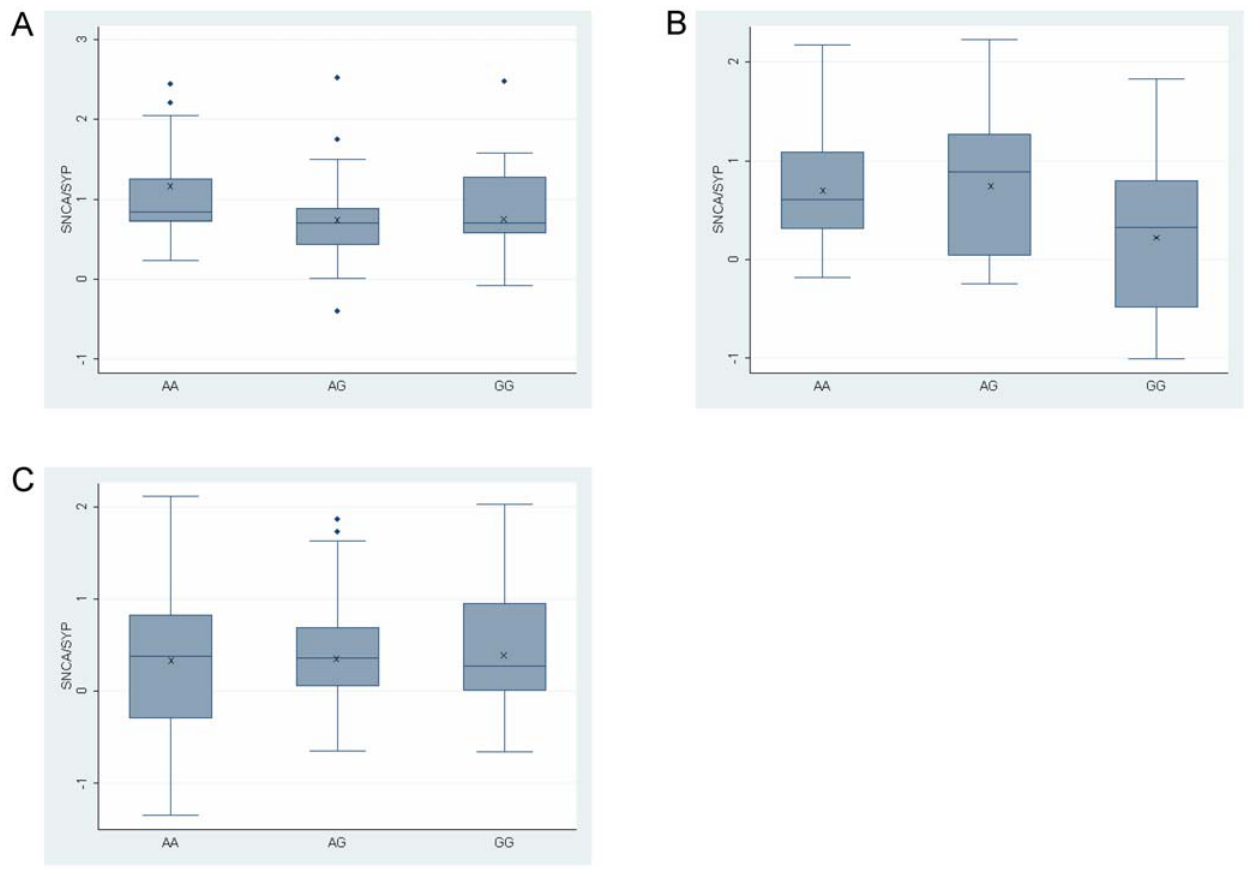
Figure 5. Effect of SNP rs365165, 3 9 region genotypes, on human SNCA -mRNA expression levels in human brains. Individuals were genotyped for SNP rs365165. Three brain regions were analyzed: temporal cortex ( A ), midbrain including SN ( B ) and frontal cortex ( C ). In each brain region fold levels of human SNCA -mRNA were assayed by real-time RT-PCR using TaqMan technology and calculated relative to human SYP -mRNA reference control using the 2 - DD Ct method. (A) Analysis of the temporal cortex showed that the protective genotype AA correlates with higher SNCA - mRNA levels than the GA and GG genotypes (P , 0.05). (B) In the midbrain including SN, the AA and AG genotypes correlate with higher SNCA-mRNA levels compared with the GG risk genotype (P , 0.05). (C) No correlations of SNP rs365165 genotypes with SNCA-mRNA levels were detected in the frontal cortex. For each genotype, the box plot represents the analysis performed using all brain samples available from the specific brain region, each of which was analyzed twice independently, each time in duplicate. The average values are presented in ‘X’. The box plot shows the median (horizontal line inside the box) and the 25 th and 75 th percentiles (horizontal borders of the box). The range between the 25th and 75th percentiles is the interquartile-range (IQR). The whiskers show the minimal and maximal values inside the main data body.